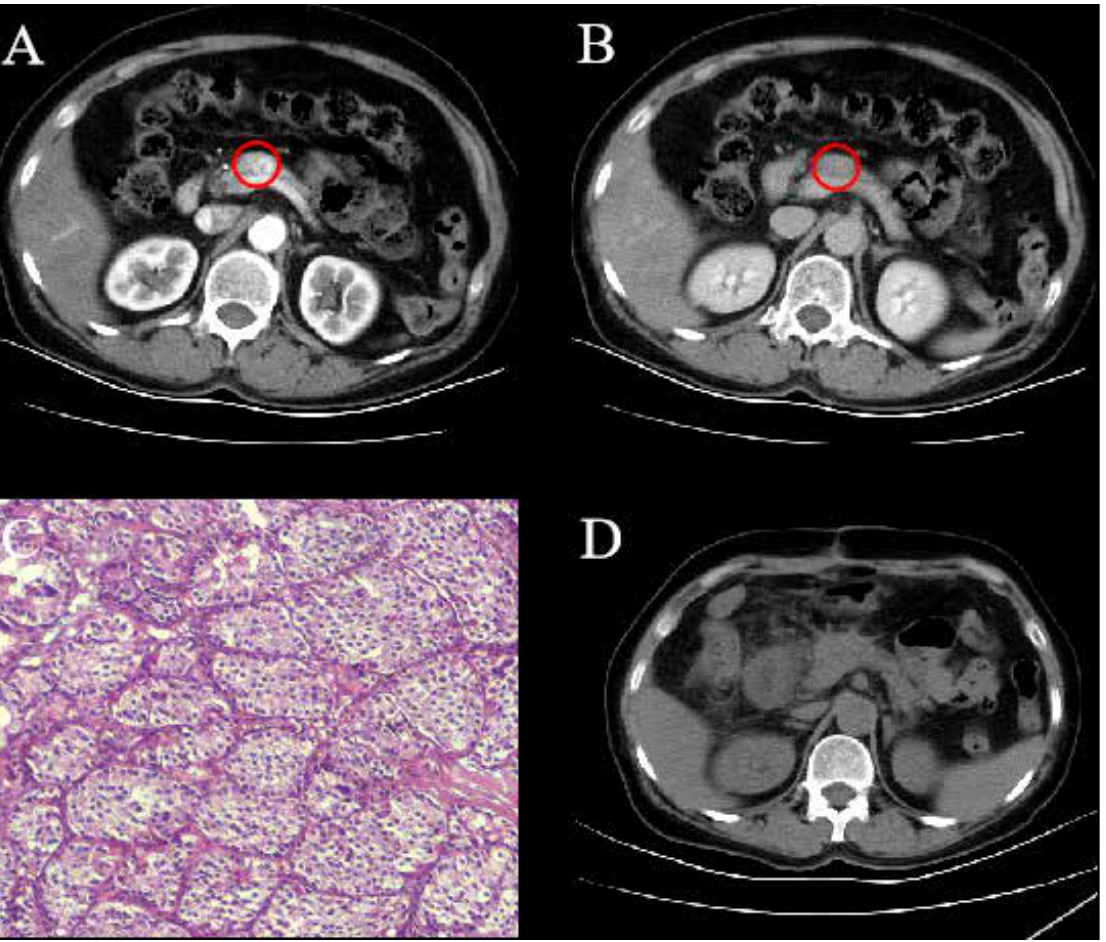
Figure 2: A 65-year-old female with insulinoma in the neck of the pancreas was treated with laparoscopic RFA. (A) Contrast-enhanced CT scan depicted a markedly enhanced lesion in the neck of the pancreas in the early arterial phase (red cycle). (B) Contrast-enhanced CT scan showed an isointense lesion in the delayed phase (red cycle). (C) Pathology confirmed the diagnosis of pancreatic insulinoma (HE×100). (D) The postoperative CT scan suggested the tumor was completely ablated.